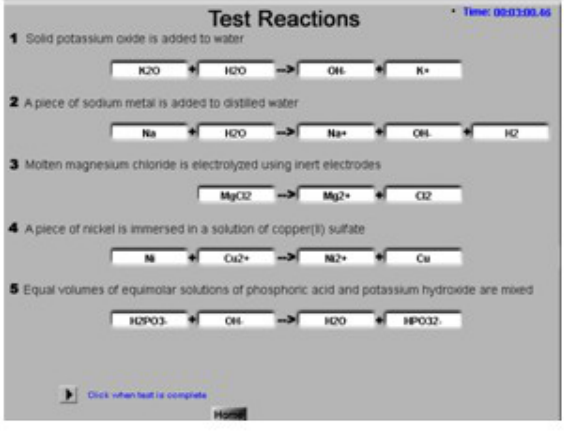
Figure 4. Test Screen with Example Inputs